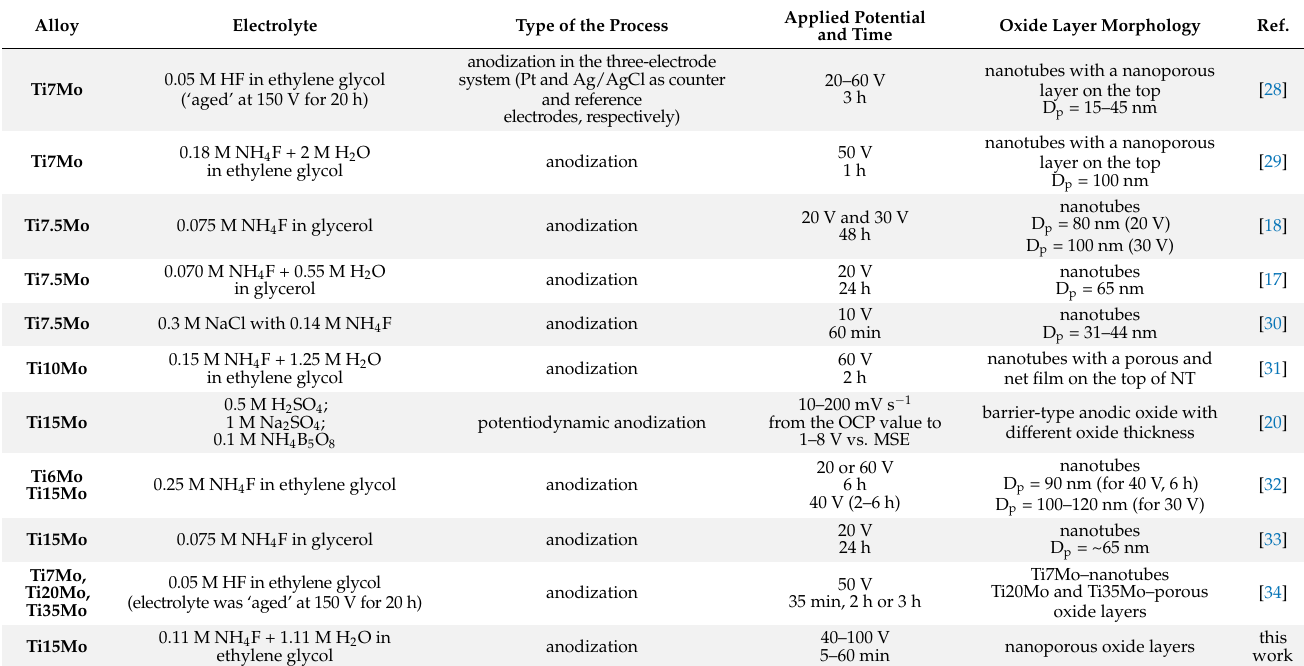
Table 1. An overview of oxidation conditions of TiMo alloys along with oxide layer morphology parameters. (D p —pore diameter, MSE - Mercury-mercurous Sulfate